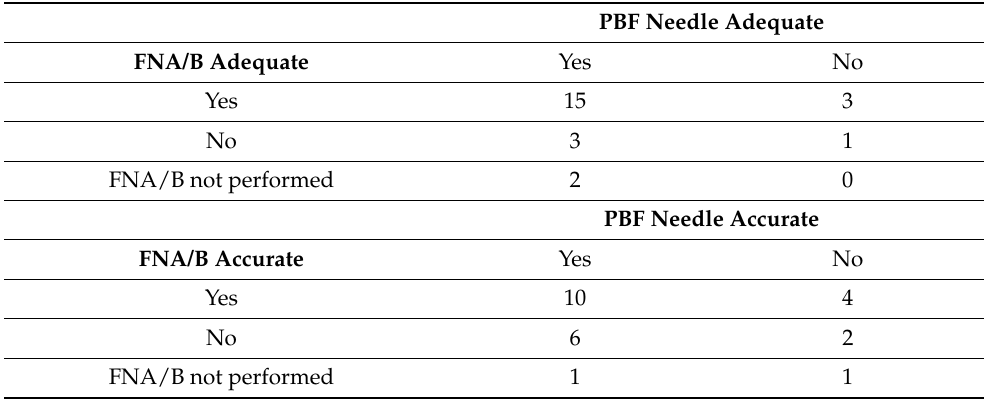
Table 2. Comparison of sample adequacy and diagnostic accuracy of the PBF needle with other FNA/B needles used.